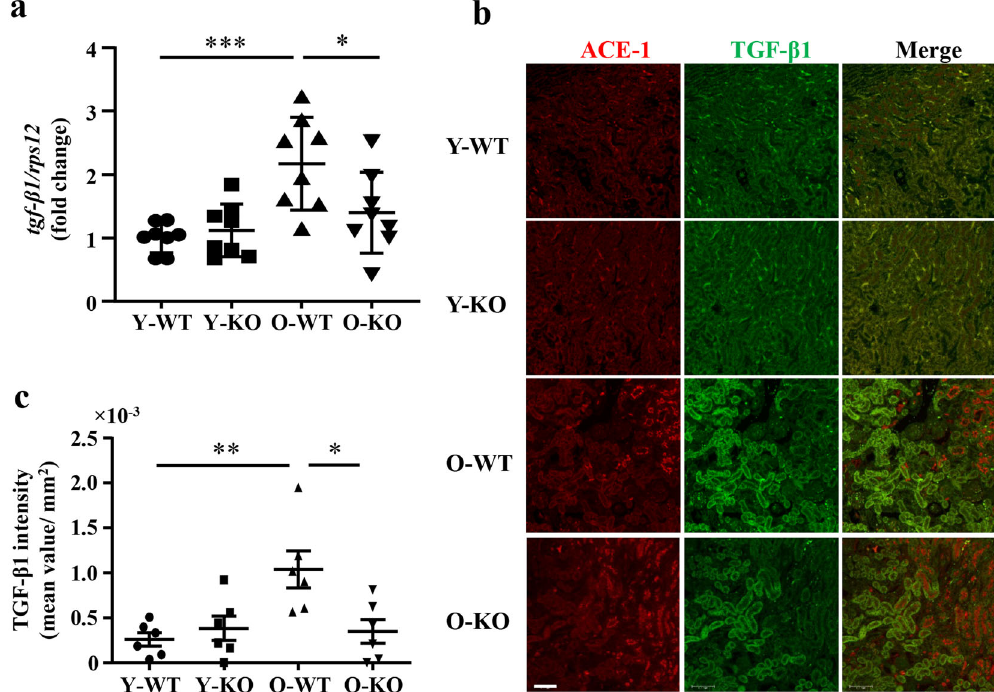
Fig. 7 Arg-II de fi ciency reduces age-associated TGF- β 1 in female mice. a mRNA levels of tgf- β 1 in young and old WT and arg-II − / − mouse kidneys analyzed by qRT-PCR; n = 8 in each group; b Central transverse renal sections (one section from each animal) were prepared from young and old WT and arg-II − / − female mice and subjected to immuno fl uorescence staining of ACE-1 (red) and TGF- β 1 (green). Representative images were selected from the outer medulla. n = 6 in each group. Scale bars = 0.1 mm. c Quanti fi cation of the intensity of fl uorescence signals of TGF- β 1. Y-WT young WT, Y-KO young arg-II − / − , O-WT old WT, O-KO old arg-II − / − . * P ≤ 0.05, ** P ≤ 0.01, *** P ≤